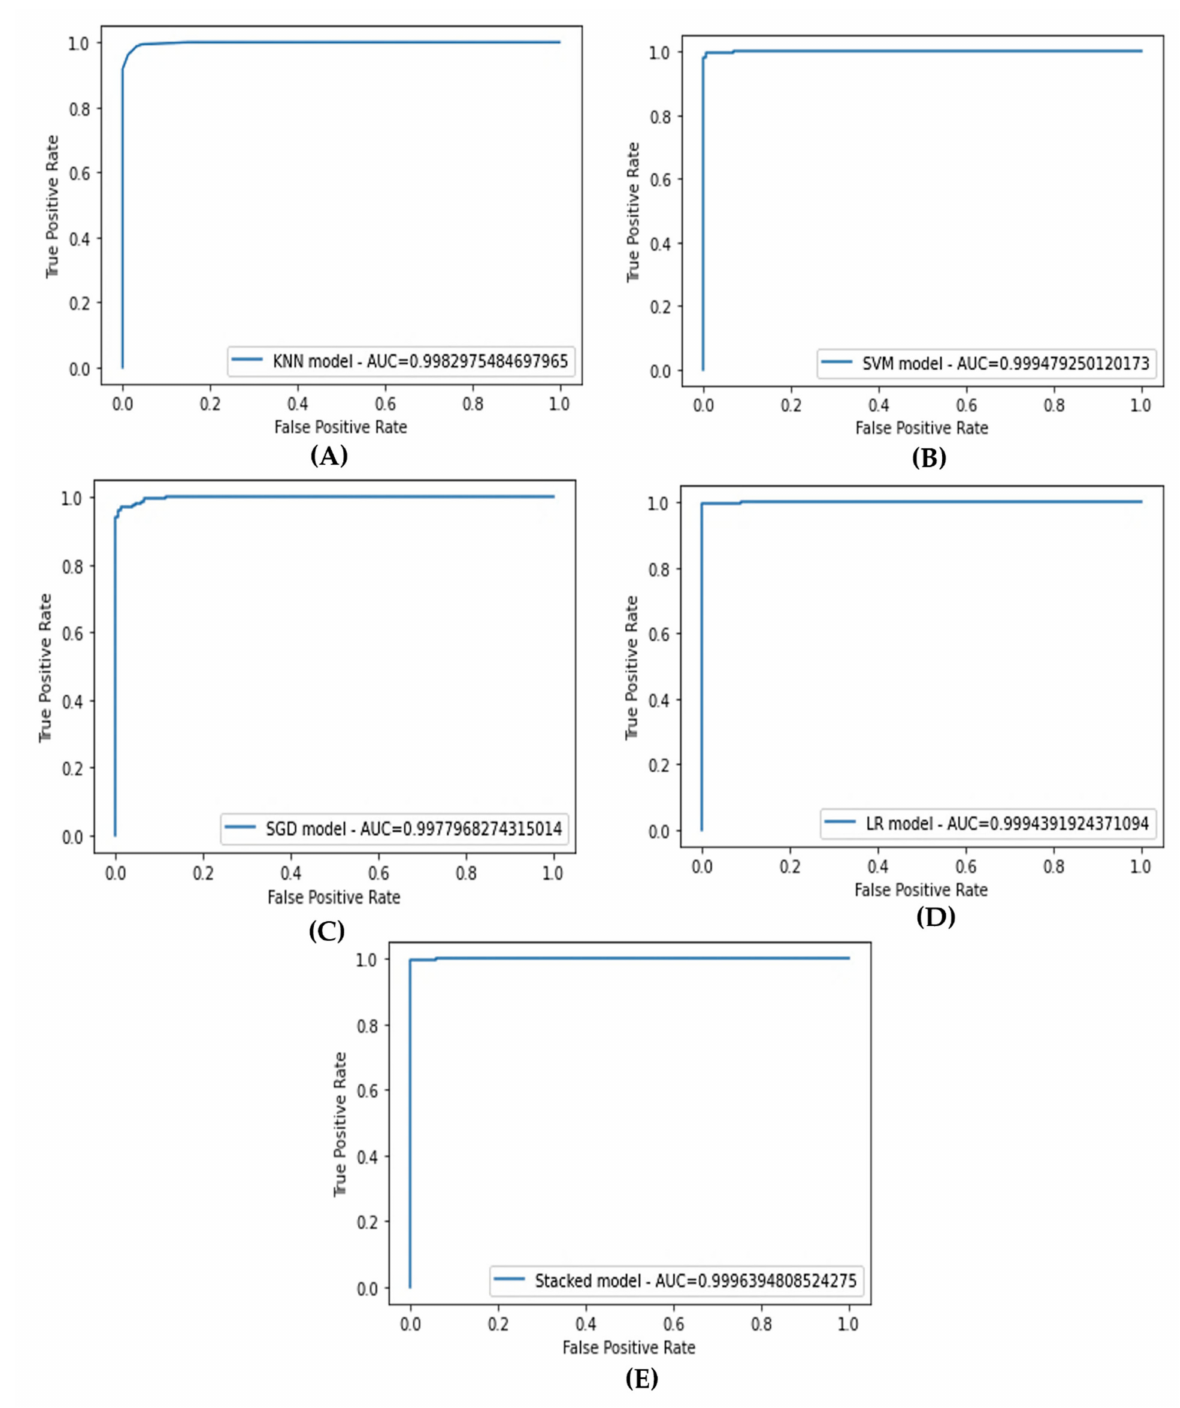
Figure 2. Area under the ROC curve for the for models: ( A ) KNN model, ( B ) SVM model, ( C ) SGD model, ( D ) LR model, and ( E ) the stacked